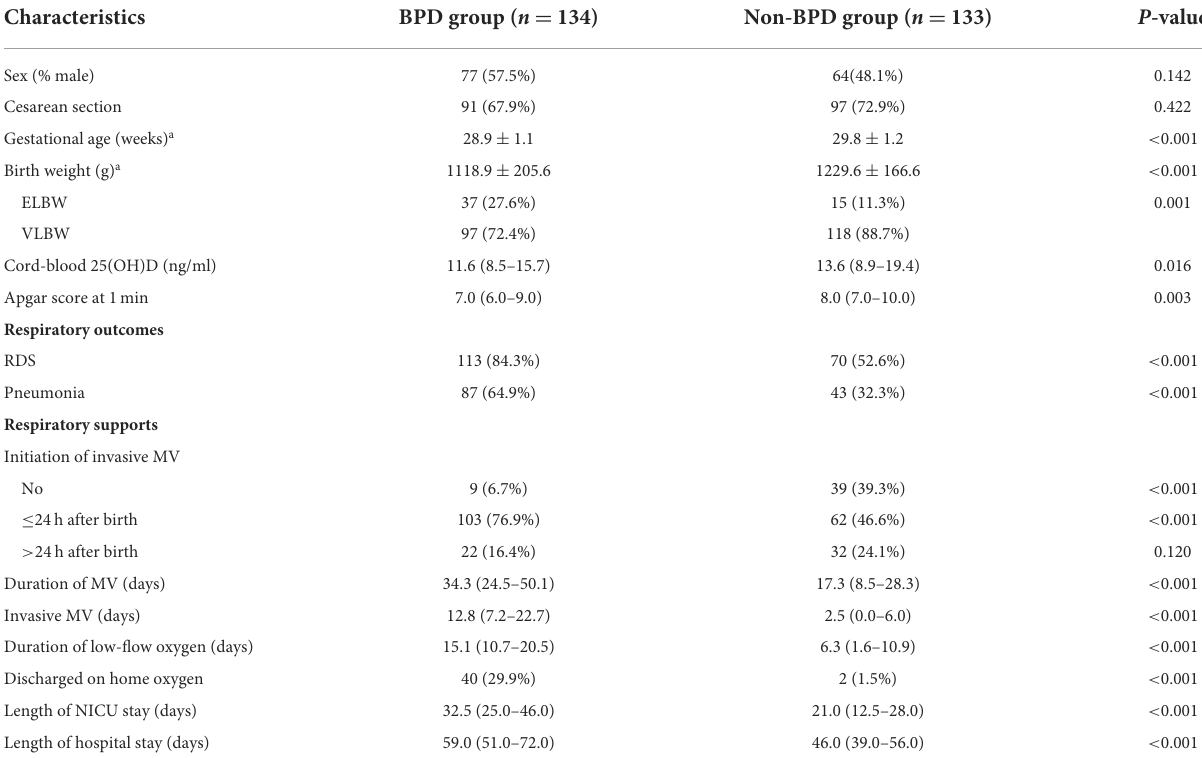
TABLE 2 Demographic and clinical characteristics of infants with and without bronchopulmonary dysplasia (BPD).